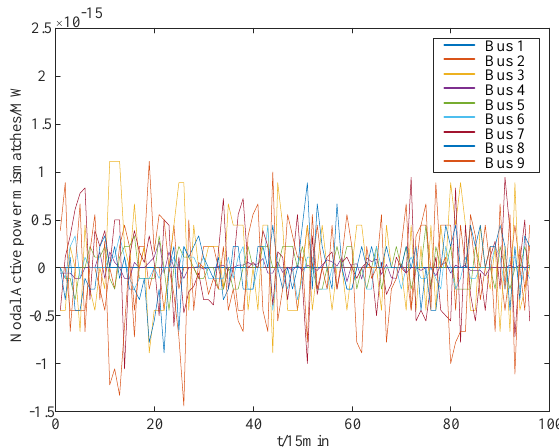
Figure 8. The nodal active power mismatches of different buses.